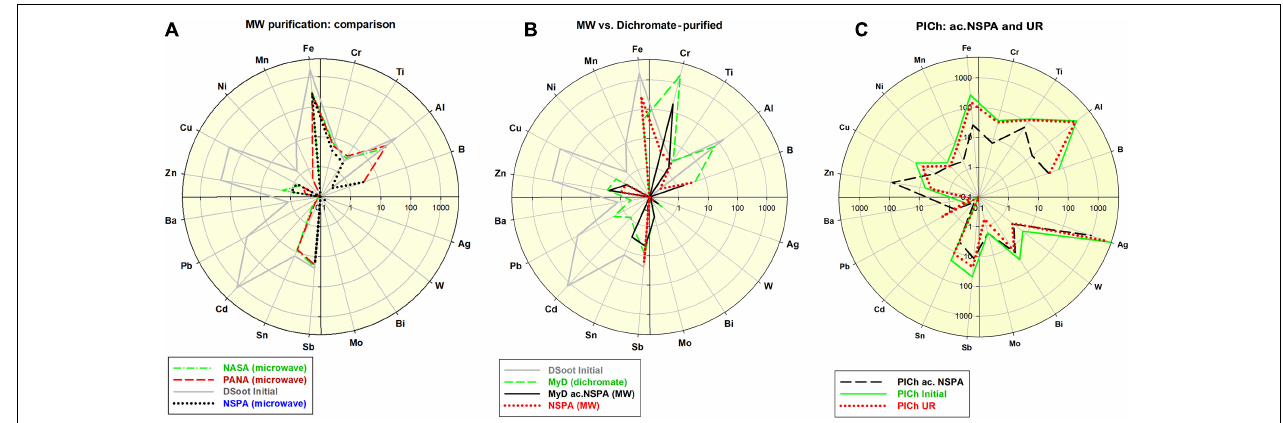
FIGURE 1 | (A) Comparative distribution of 18 non-carbon impurity elements in the initial DSoot, vs. microwave-purified DND of types NASA, PANA and NSPA (ppm, logarithmic scale 0.1–4,000; check also Supp. Information 4 ); (B) Elemental distribution of acid-dichromate purified DND type MyD, compared with that of the parent DS, MW-purified NSPA and MW-refined MyD (MyD ac.NSPA); scale 0.1–5,000; (C) Elemental content of initial PlCh, PlCh ac.NSPA and PlCh UR; scale